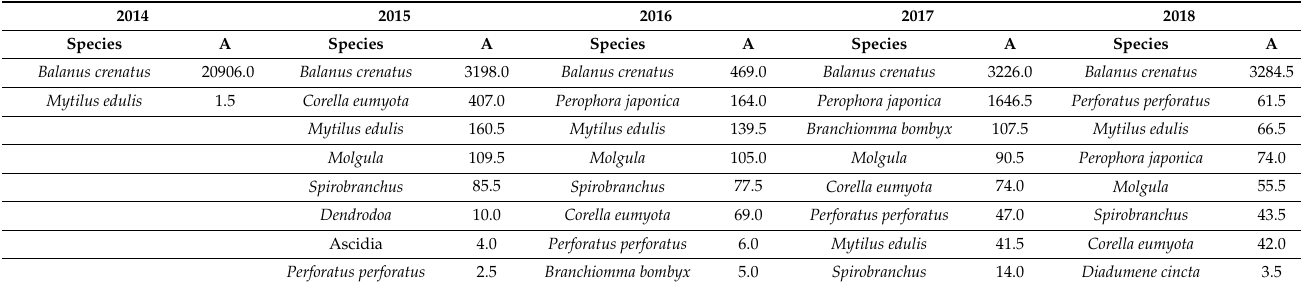
Table 4. Mean abundance (A per 0.6 m 2 ) of the eight dominant sessile species found on the two blocks sampled from 2014 to 2018 (one, two, three and four years after the beginning of the